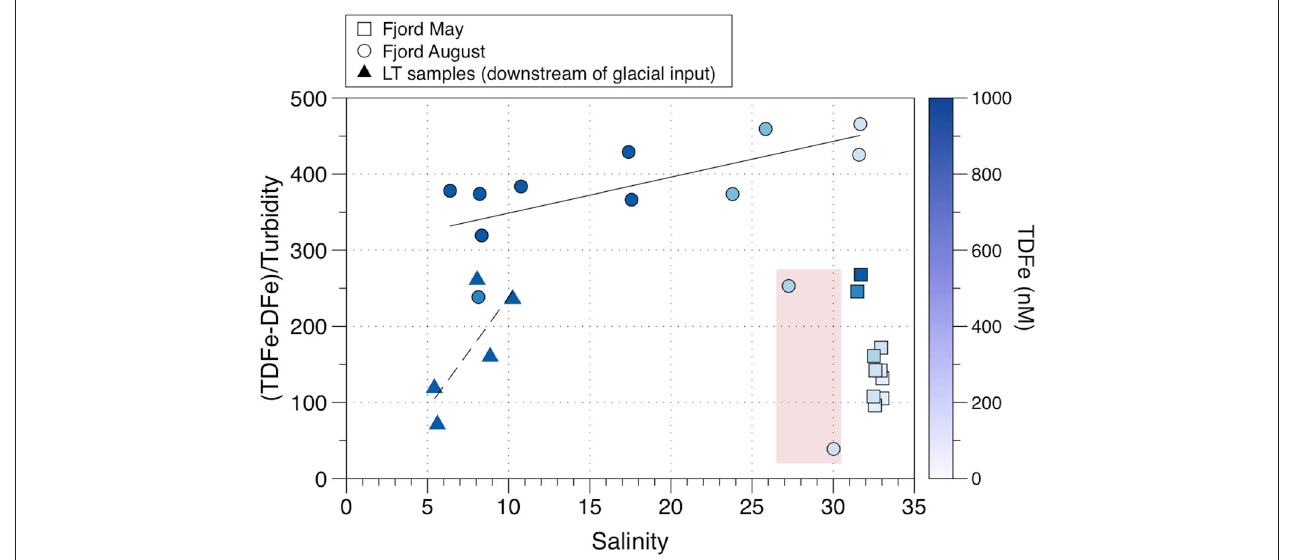
FIGURE 11 | Variations in the ratio of (TDFe-DFe)/Turbidity (measured as OBS or Optical Back Scattering) with salinity in Godthabsfjord (Greenland). The dash lined indicates a linear best fit of LT samples (low salinity, high turbidity meltwater plume), and the solid line indicates a best fit of other August fjord samples (excluding outlier stations GF4 and GF5, highlighted in red). Data from Hopwood et al.